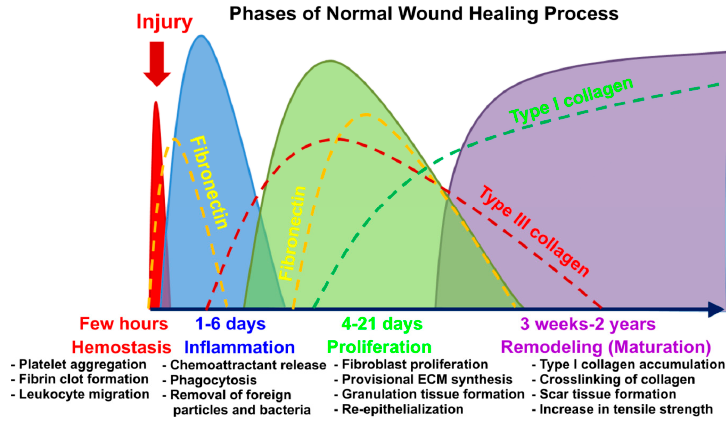
Figure 1. Graphical representation of the four phases of the normal wound healing process.